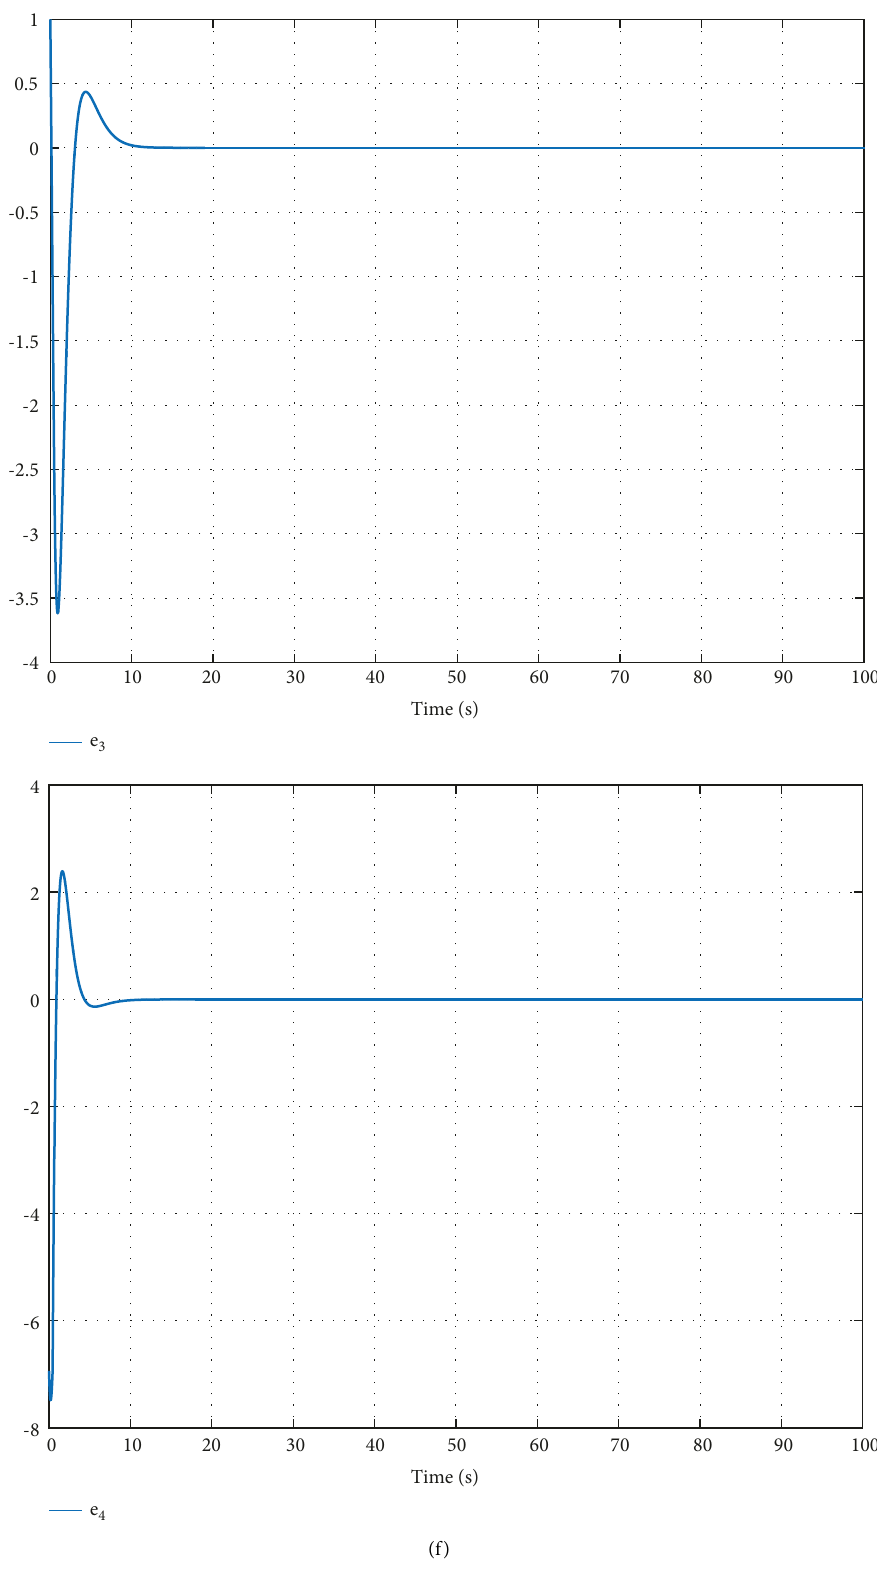
Figure 3: Antisynchronization of identical 4D hyperchaotic financial system. (a) Antisynchronization of interest rate corresponding to ( 0 ) , y ( 0 ) � ( 3 , − 2 )] . (b) Antisynchronization of investment demand corresponding to the initial condition initial condition [ x 1 1 [ x ( 0 ) , y ( 0 ) � ( 1 , 3 )] . (c) Antisynchronization of price index corresponding to initial condition [ x 2 2 synchronization of average profit margins corresponding to the initial condition [ x e ,e , e , and e 1 2 3 4